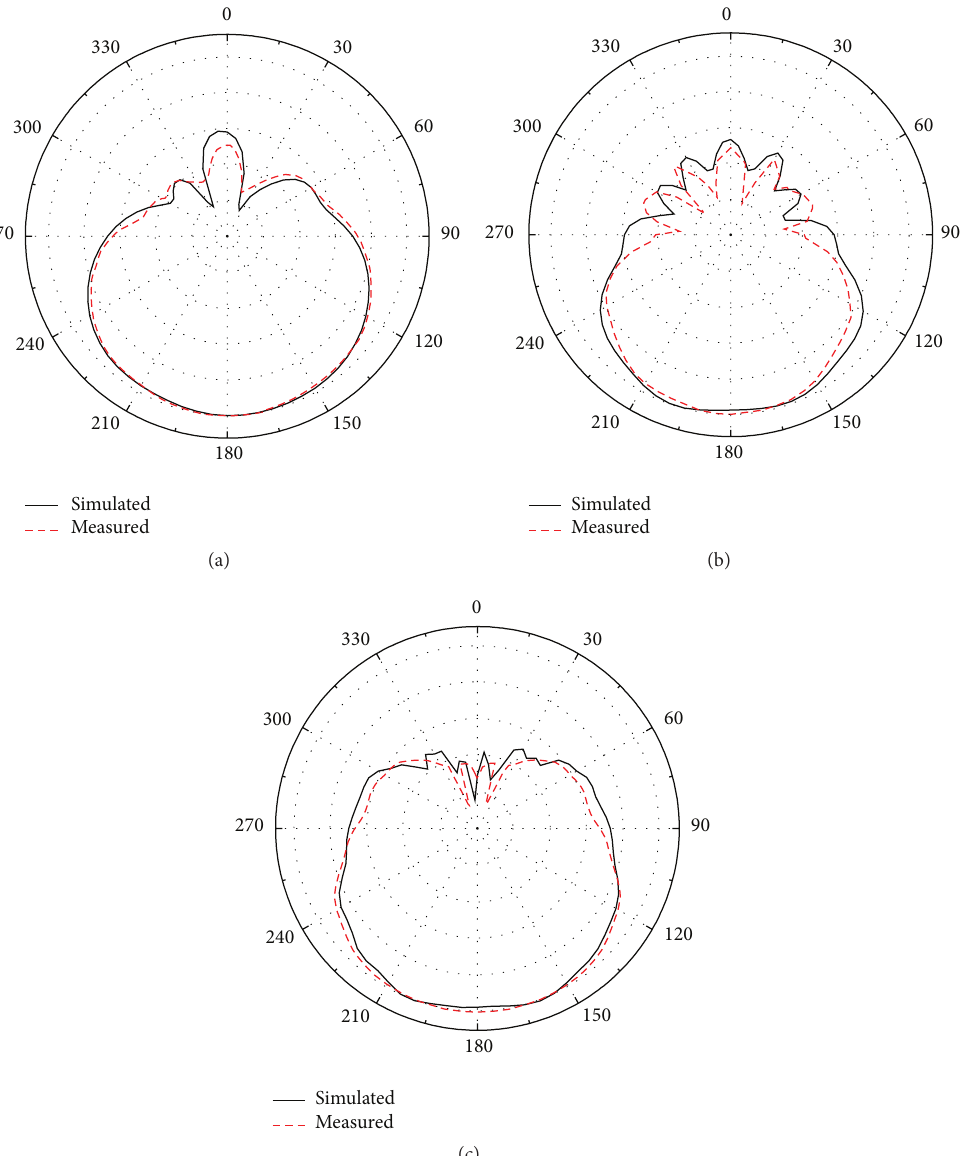
Figure 6: Normalized radiation patterns of E-plane: (a) 250 MHz; (b) 500 MHz; (c) 750